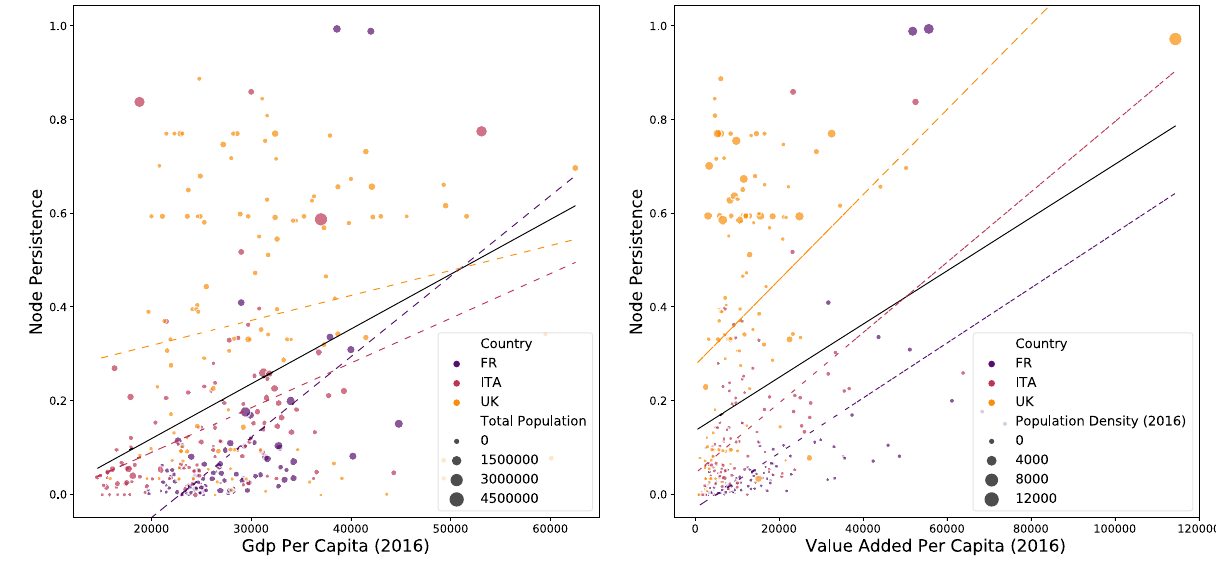
Figure 4. Correlation of node persistence with economic and demographic variables. Left panel: correlation between Node Persistence and GDP per Capita in 2016, with the size of nodes corresponding to Total Population in 2018. Right panel: correlation between Node Persistence and Value Added per Capita in 2016, with the size of nodes corresponding to Population Density in 2018. Overall correlation is significantly positive with respect to GDP per Capita (P–R: P ∼ 0 R = 0.37 ; S–R: P ∼ 0 R = 0.39 ; K–T: P ∼ 0 R = 0.27 ) and Valued Added per Capita (P–R: P ∼ 0 R = 0.3 ; S–R: P ∼ 0 R = 0.4 ; K–T: P ∼ 0 R = 0.27 ). Country correlations with Value Added per Capita are positive and significant for all countries, while for GDP per Capita are positive and significant only for Italy and France but not for UK (full results reported in section “Materials and methods”). Nodes have been aggregated at the province level to match economic variables. Colors of scatter points correspond to three countries in the sample. Full sample regression line reported as the continuous black line, while regressions lines for single countries are reported as colored dashed lines. Top 1% of the nodes by GDP Per Capita (left) or Value Added per Capita (right) has been removed to avoid the influence of outlier values and ease visualization (correlation results for the full sample are reported in “Materials and